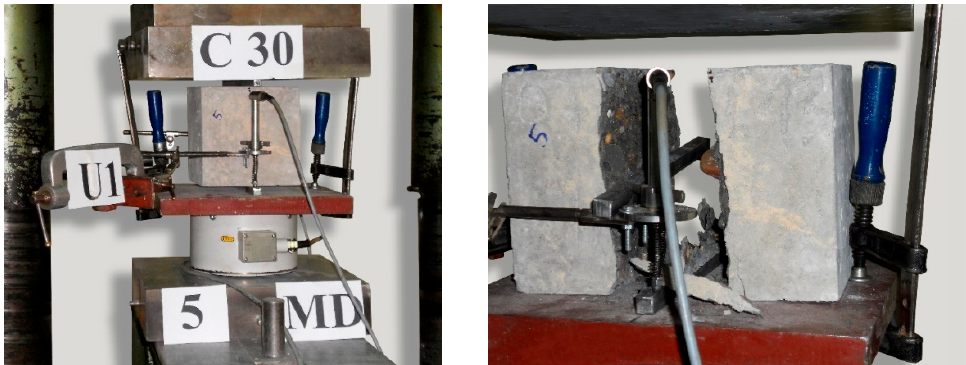
Table 6. Average compressive and tensile strengths for different concrete series.